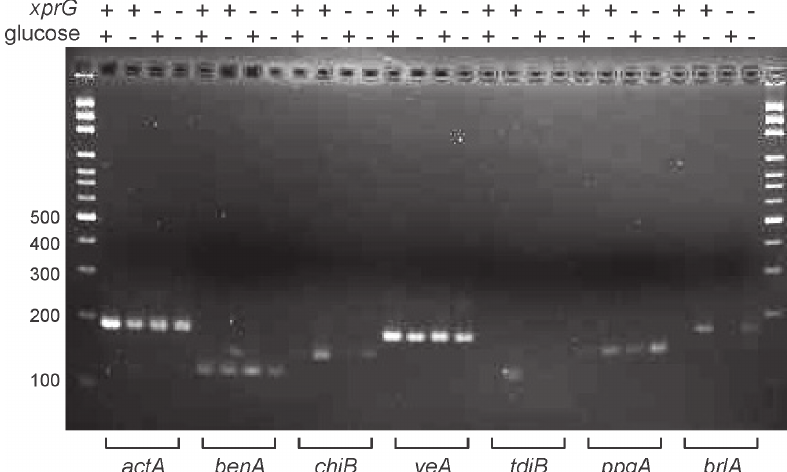
Supplementary Figure 1. Agarose gel electrophoresis of qRT-PCR products . The template was total RNA extracted from an xprG + (+) and xprG D 1 (−) strains transferred to glucose (+) or carbon-free medium (−) for 16 h. A 100 bp ladder (Axygen) was used as a standard in the first and last lanes of the 2% agarose gel. The full genotypes of the xprG + strain (MH2) and the xprG D 1 strain (MK422) are given in Table